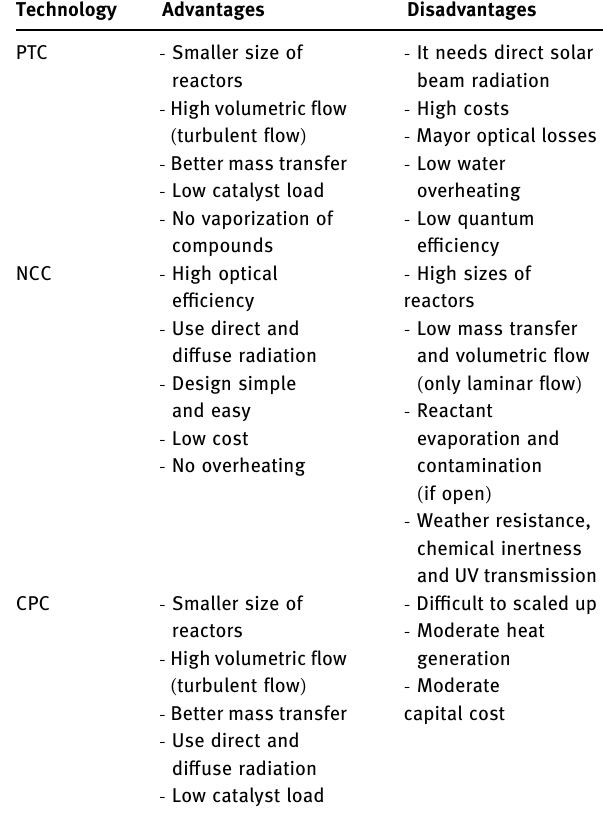
Table 10: Comparison of collector technologies for decontamination processes Technology